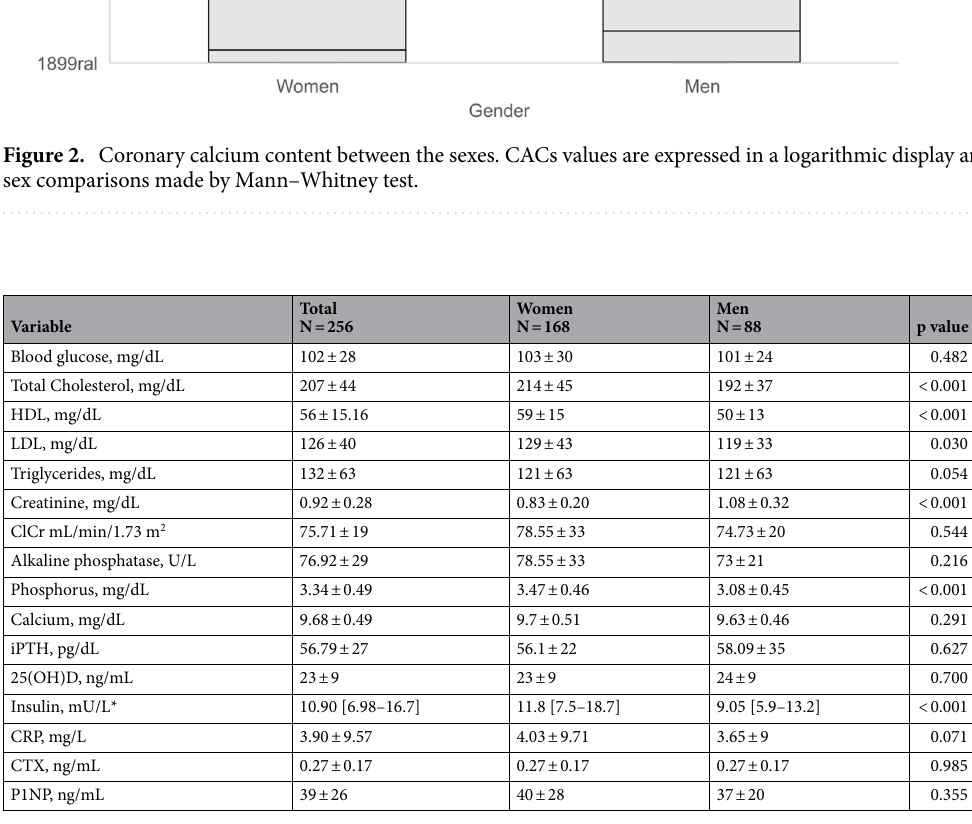
Table 2. Laboratory characteristics of 256 older adults, separated by sex. The mean ± standard deviation was adopted for all variables ( t test), except for insulin* represented with median + interquartile range 25–75 (Mann–Whitney U test); HDL high-density lipoprotein, LDL low-density lipoprotein, ClCr estimated creatinine clearance, iPTH parathyroid hormone, 25OHD 25-hydroxyvitamin D, CRP C-reactive